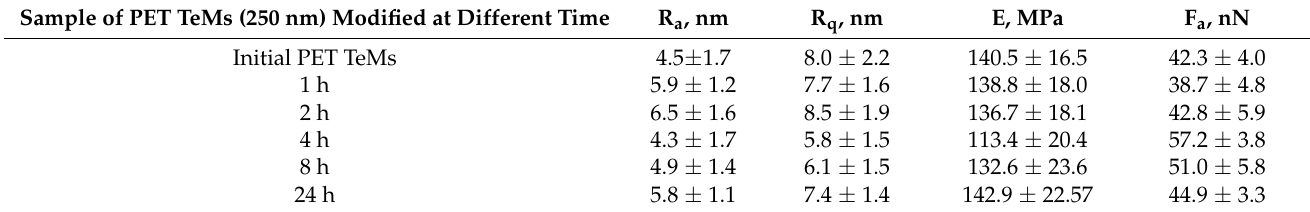
Table 3. Results of atomic force microscopy.